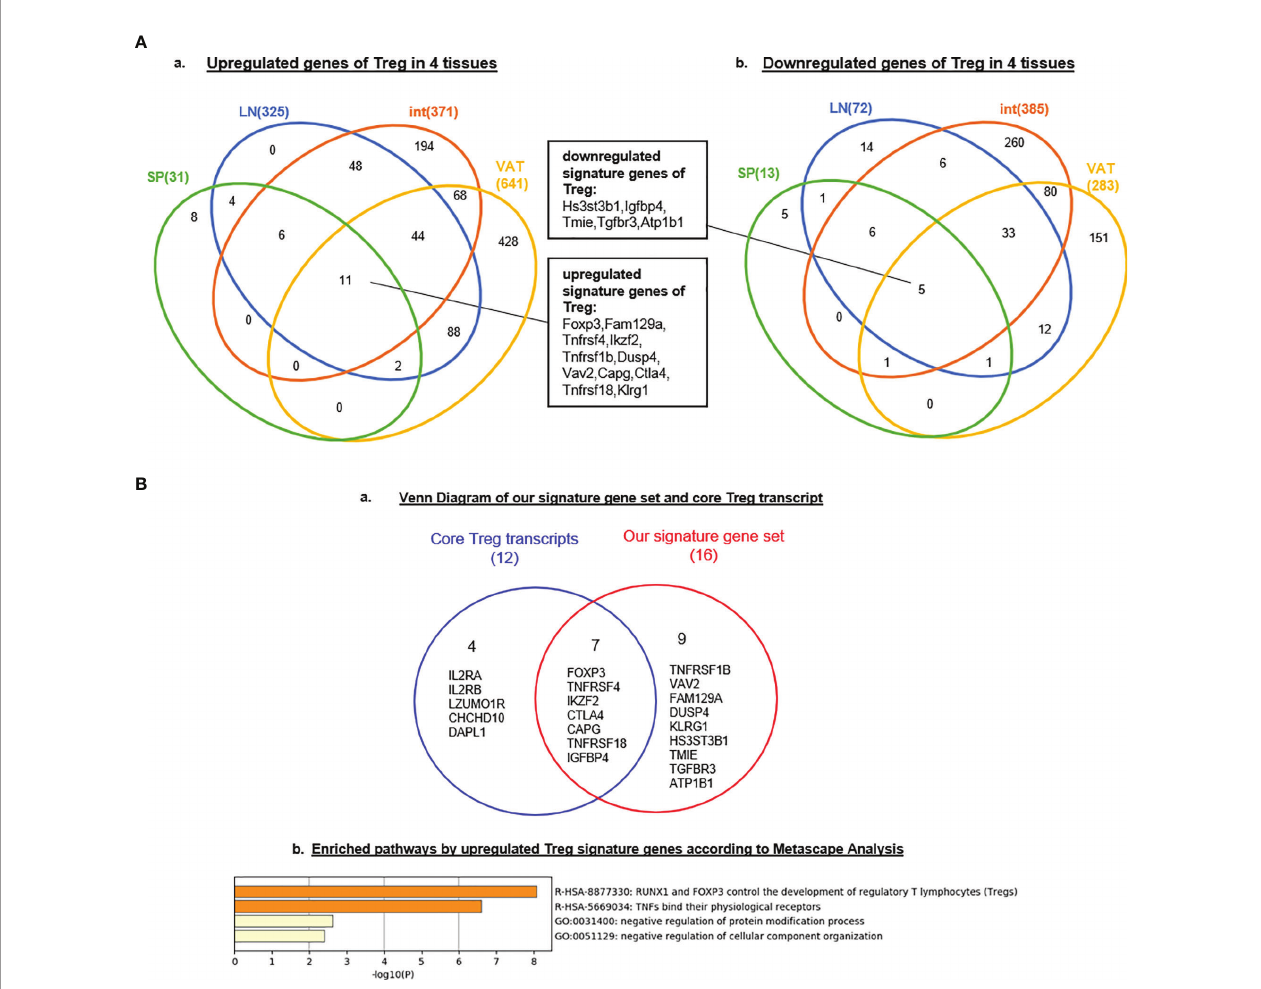
FIGURE 1 | (A) Nine new Treg signature genes are identi fi ed. Venn Diagram showed the signature genes of Treg commonly upregulated (left) and downregulated (rignt) in four tissues we studied, indicating the same source or progenitor of Treg in different tissues. These shared genes could be identi fi ed as signature genes of regulatory T cell. (B) RUNX1 and Foxp3 regulate tumor necrosis factors (TNFs) and their receptors. We compared 16 signature genes (11 upregulated genes and 5 downregulated genes in Figure 1) with core Treg transcripts in spleen identi fi ed by single-cell RNA-seq (PMID: 29434354). Nine genes of our signature gene set